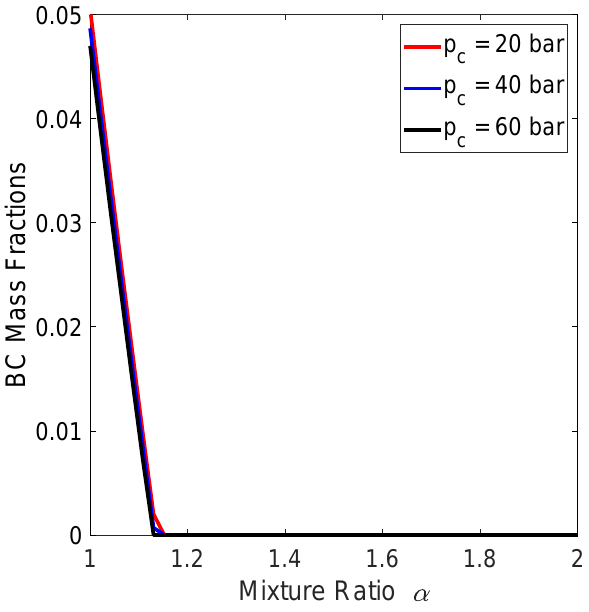
Figure 4. Carbon soot formation